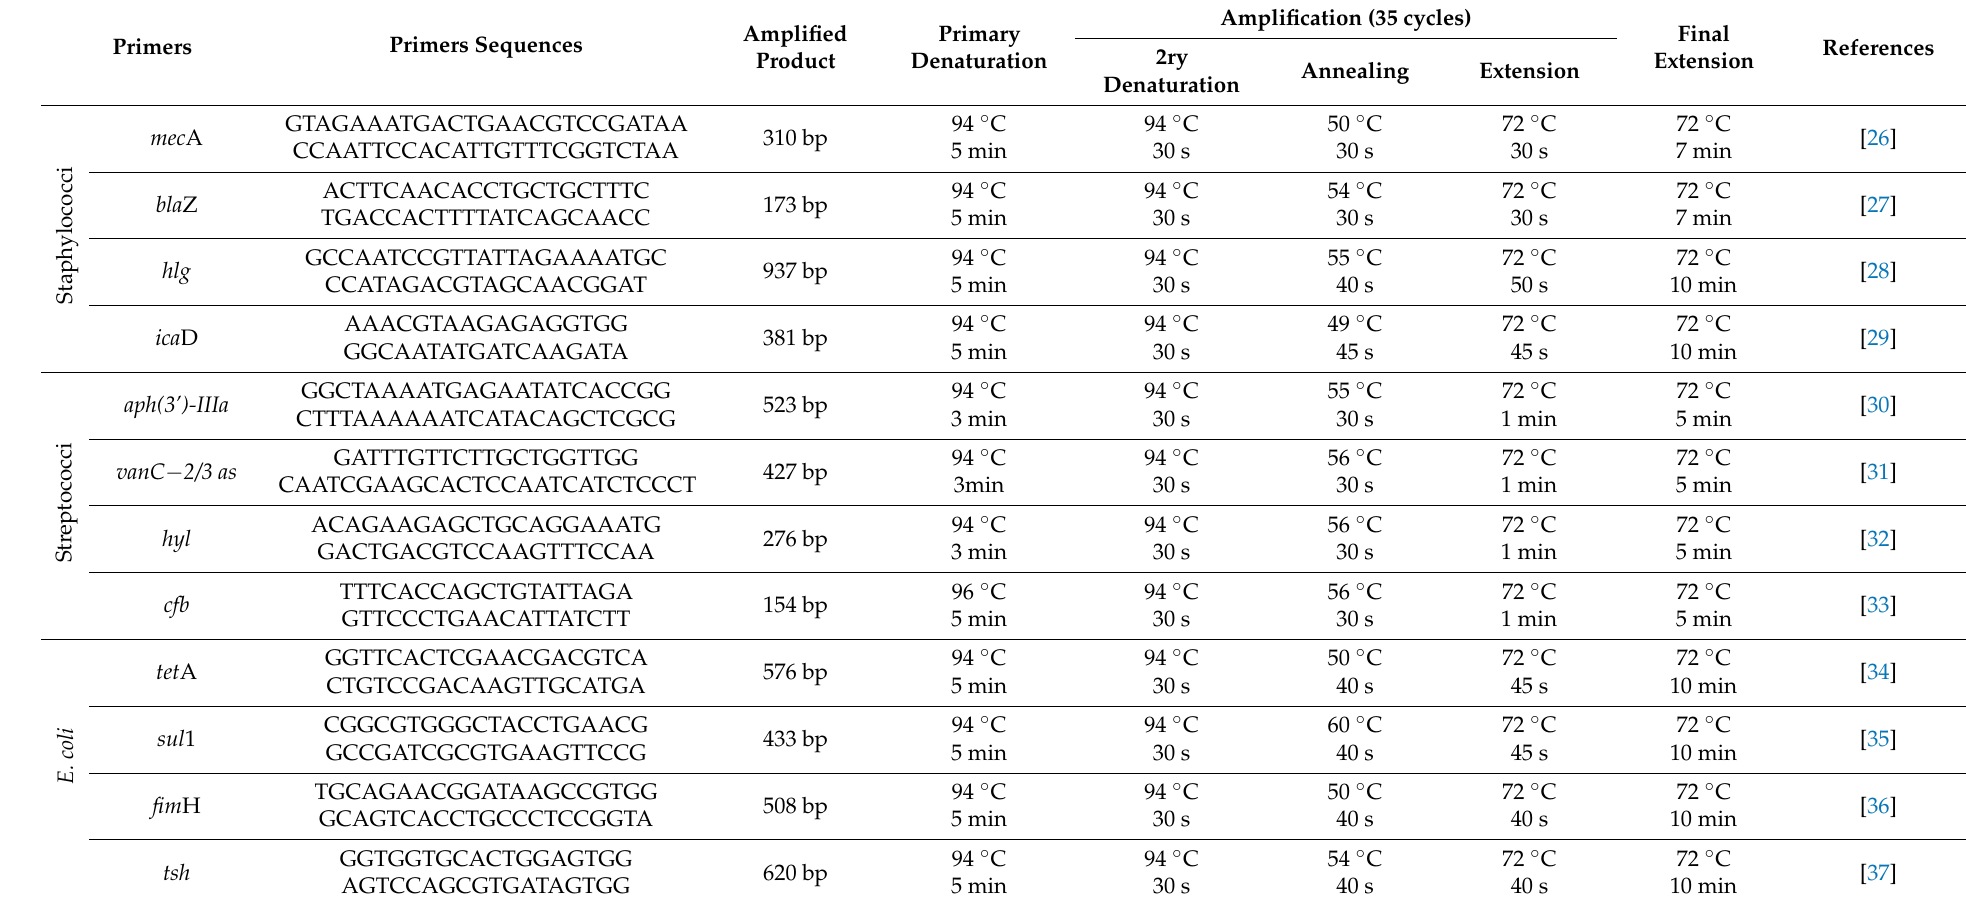
Table 1. Primers sequences, target genes, amplicon sizes and cycling